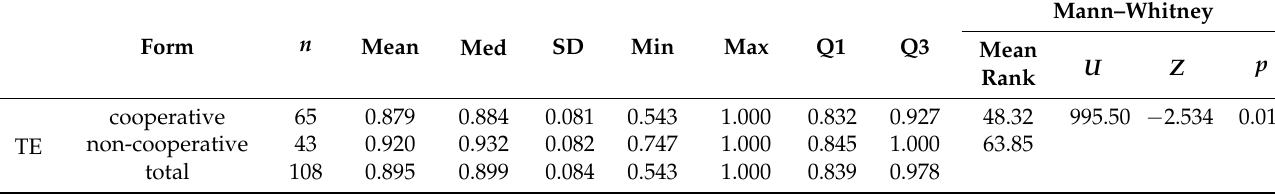
Table 3. Descriptive statistics of TE scores and results of Mann–Whitney U test (authors’ calculations based on